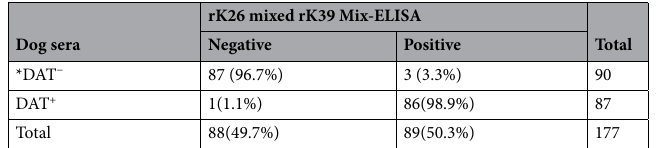
Table 2. Comparison between DAT and mixed rK39 and rK26 antigen results on canine serum samples. *DAT − contain healthy dogs (n = 74) and other infectious diseases (n = 16) as control group.